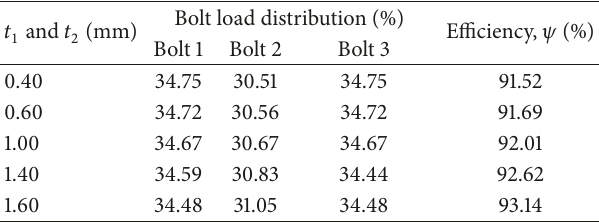
Table 7: Bolt load distribution for variation in plate thickness. 𝑡 𝑡 1 and 2 (mm)